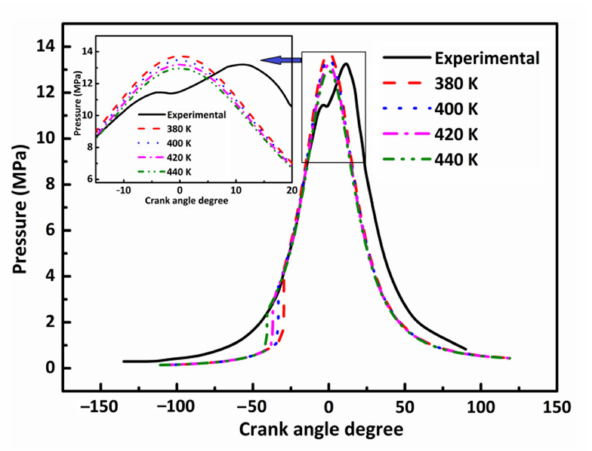
Figure 7. Effect of initial combustion temperatures on in-cylinder pressure.